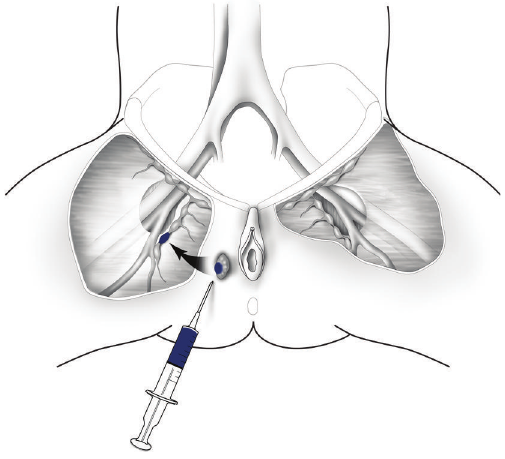
Figure 3: Sentinel lymph node mapping. Sentinel lymph nodes are localized by perilesional injection of 99mTc radiocolloid and isosulfan blue